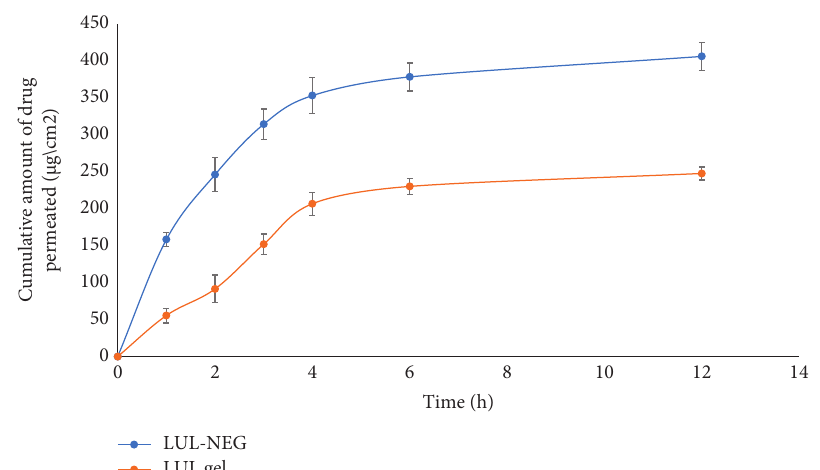
Figure 6: Cumulative amount of LUL permeation from LUL-NEG and LUL gel across the experimental rat skin. The results were presented as mean ± SD ( n � 3).